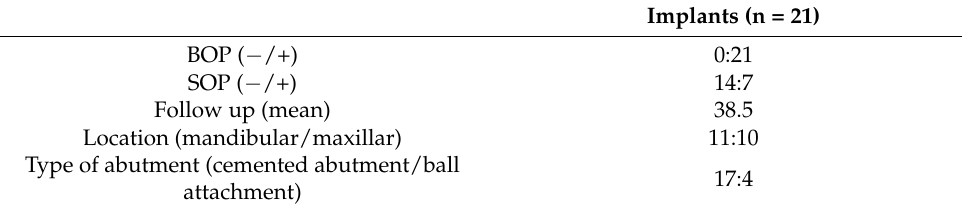
Table 2. Demographic characteristics of implants with